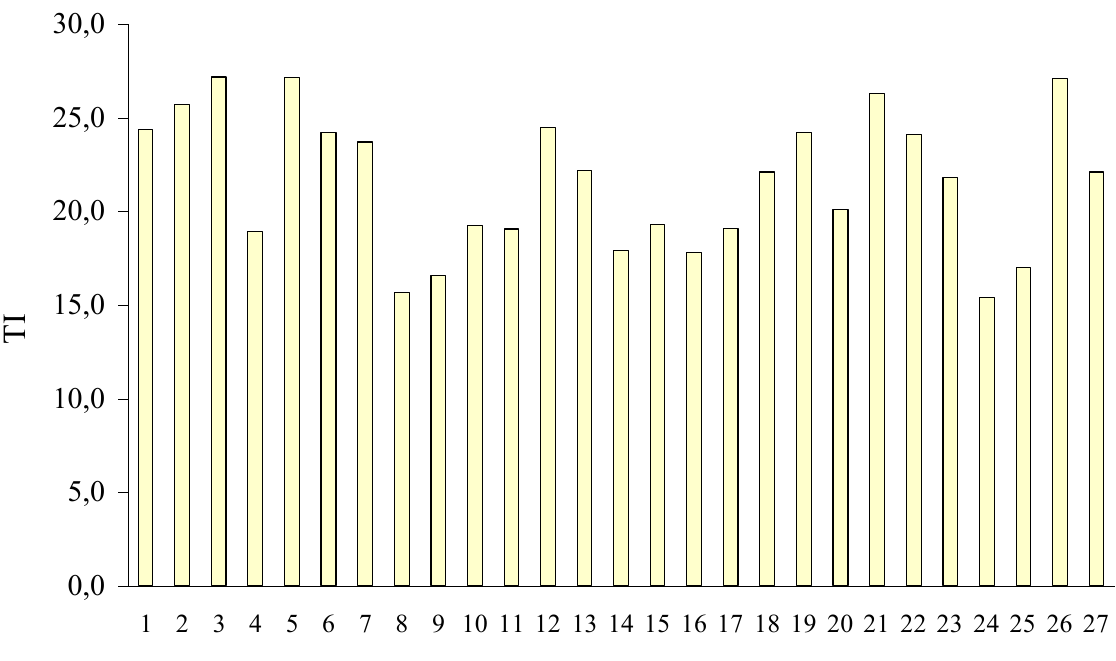
Fig.1. Individual differences between CRS’ responses to loads in process of fulfillment of tests «8», «40» and «3х3» of testing system “Spuderg-10”: TI – training impulse, indicator of response of cardi-respiratory system; S –